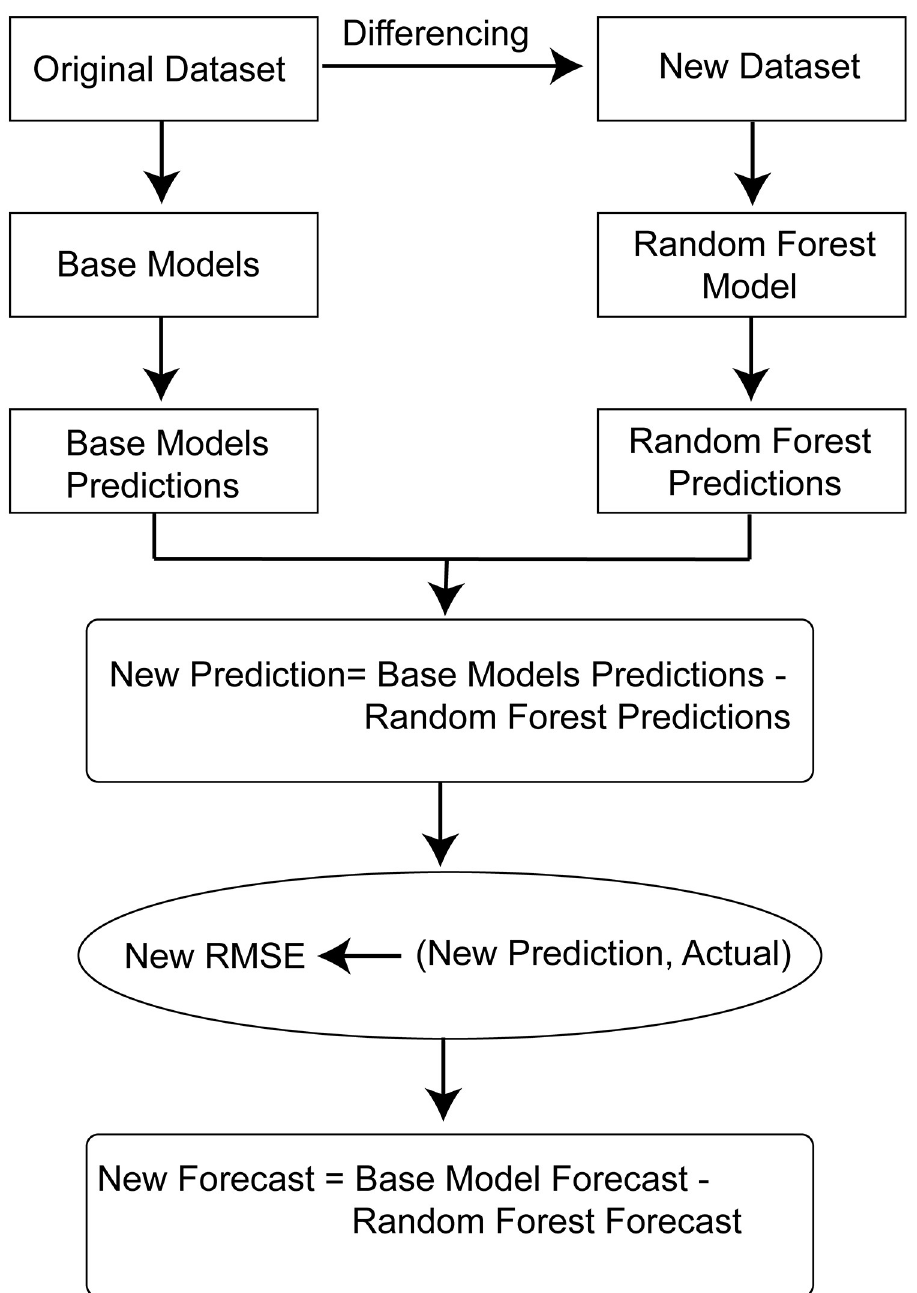
Fig 1. Proposed pipeline architecture for USD/BDT exchange rate